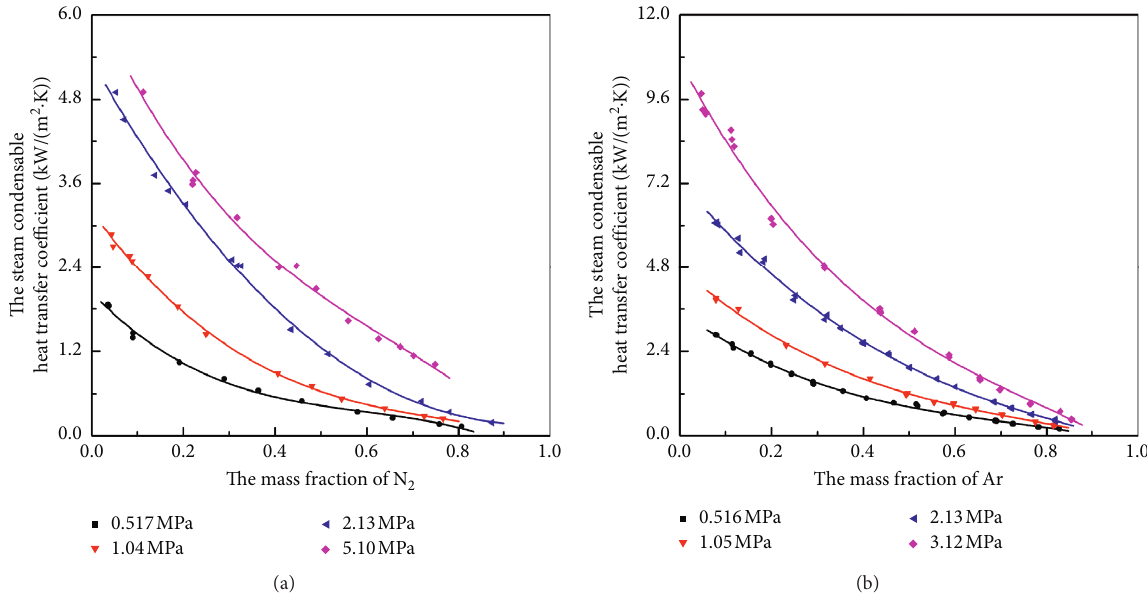
Figure 8: Effects of the mass fraction of noncondensable gas. (a) N